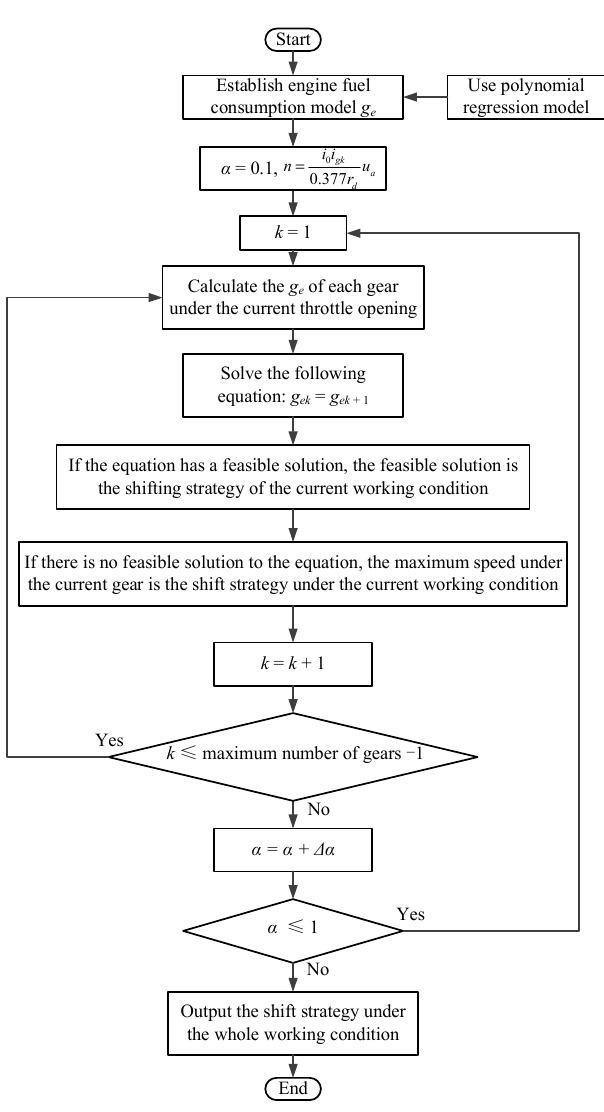
Figure 3. Flow chart of the method for obtaining SAT gear-shift strategy.